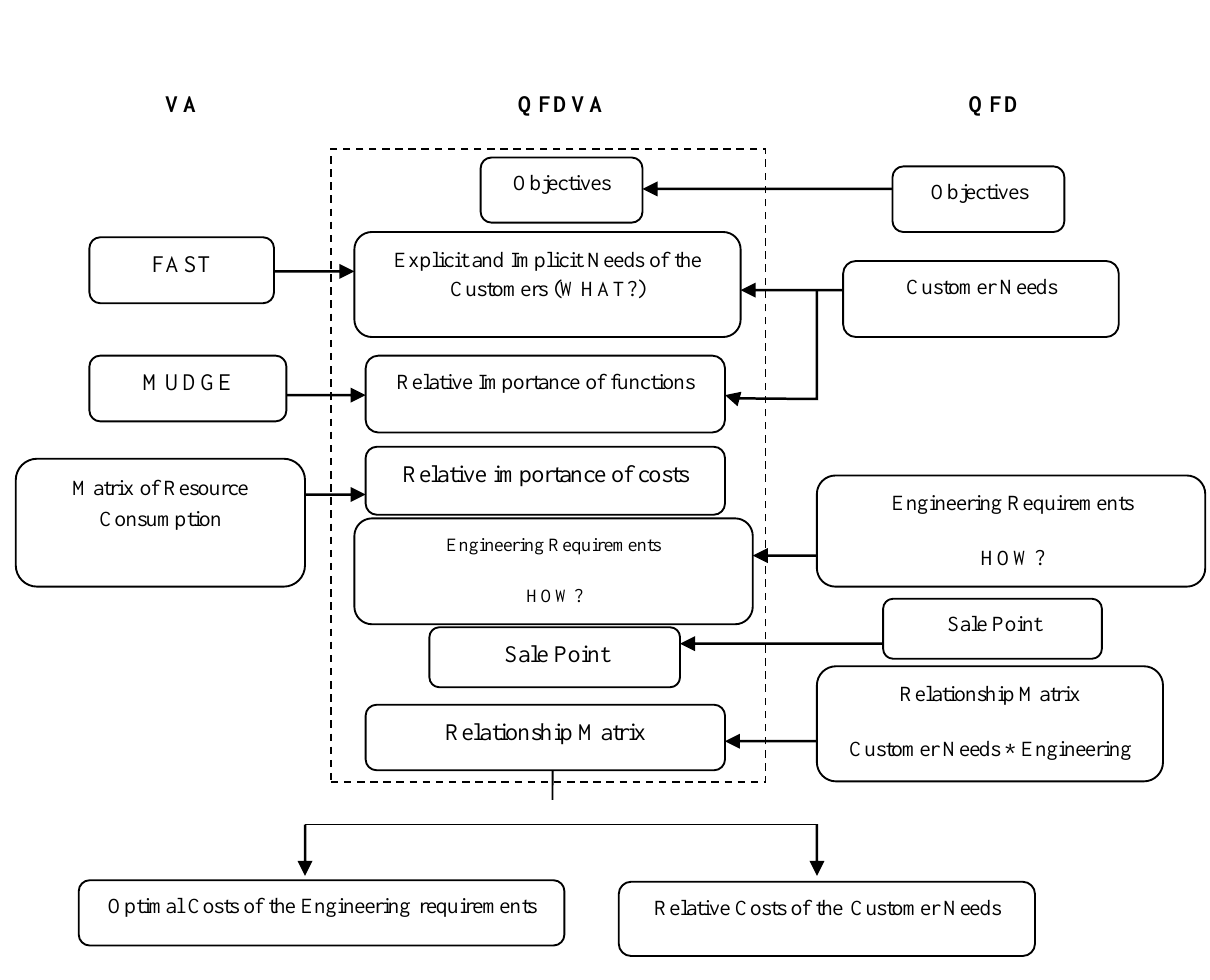
Figure 1. The composition of the QFDVA process